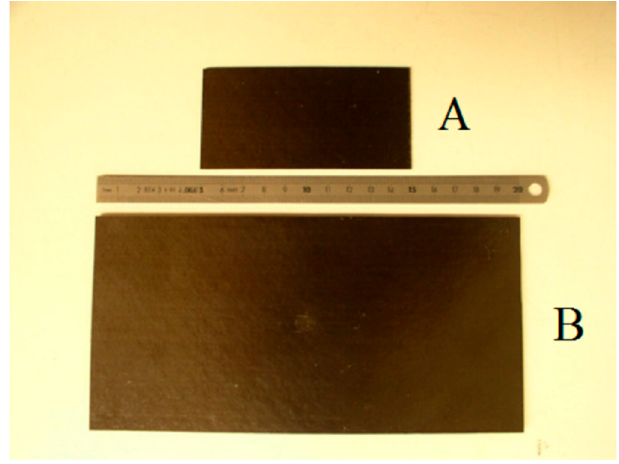
Figure 2. Samples in the experimental tests [16].